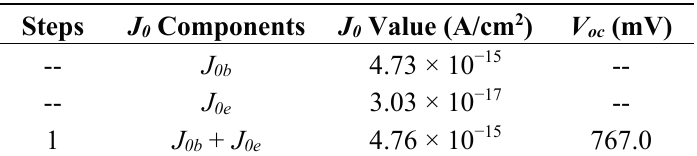
Table 1. J 0 components, values and their corresponding V oc values when SRV is 0 cm/s. J 0e is the reverse saturation current density in the emitter, J 0b is the reverse saturation current density in the base and FSF